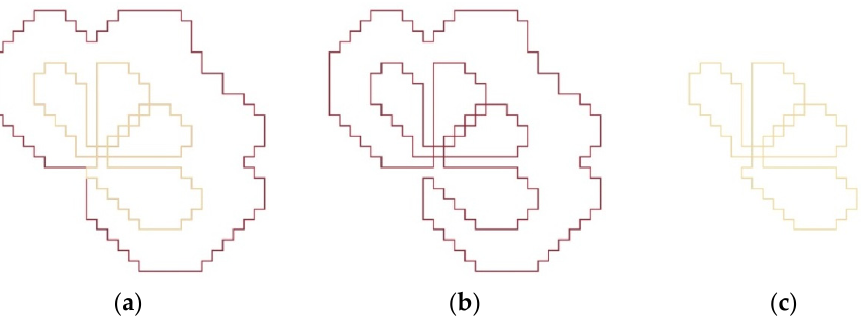
Figure 2. The drawing and the decomposition of the detail from the model: ( a ) complete contour; ( b ) burgundy contour; ( c ) beige contour.